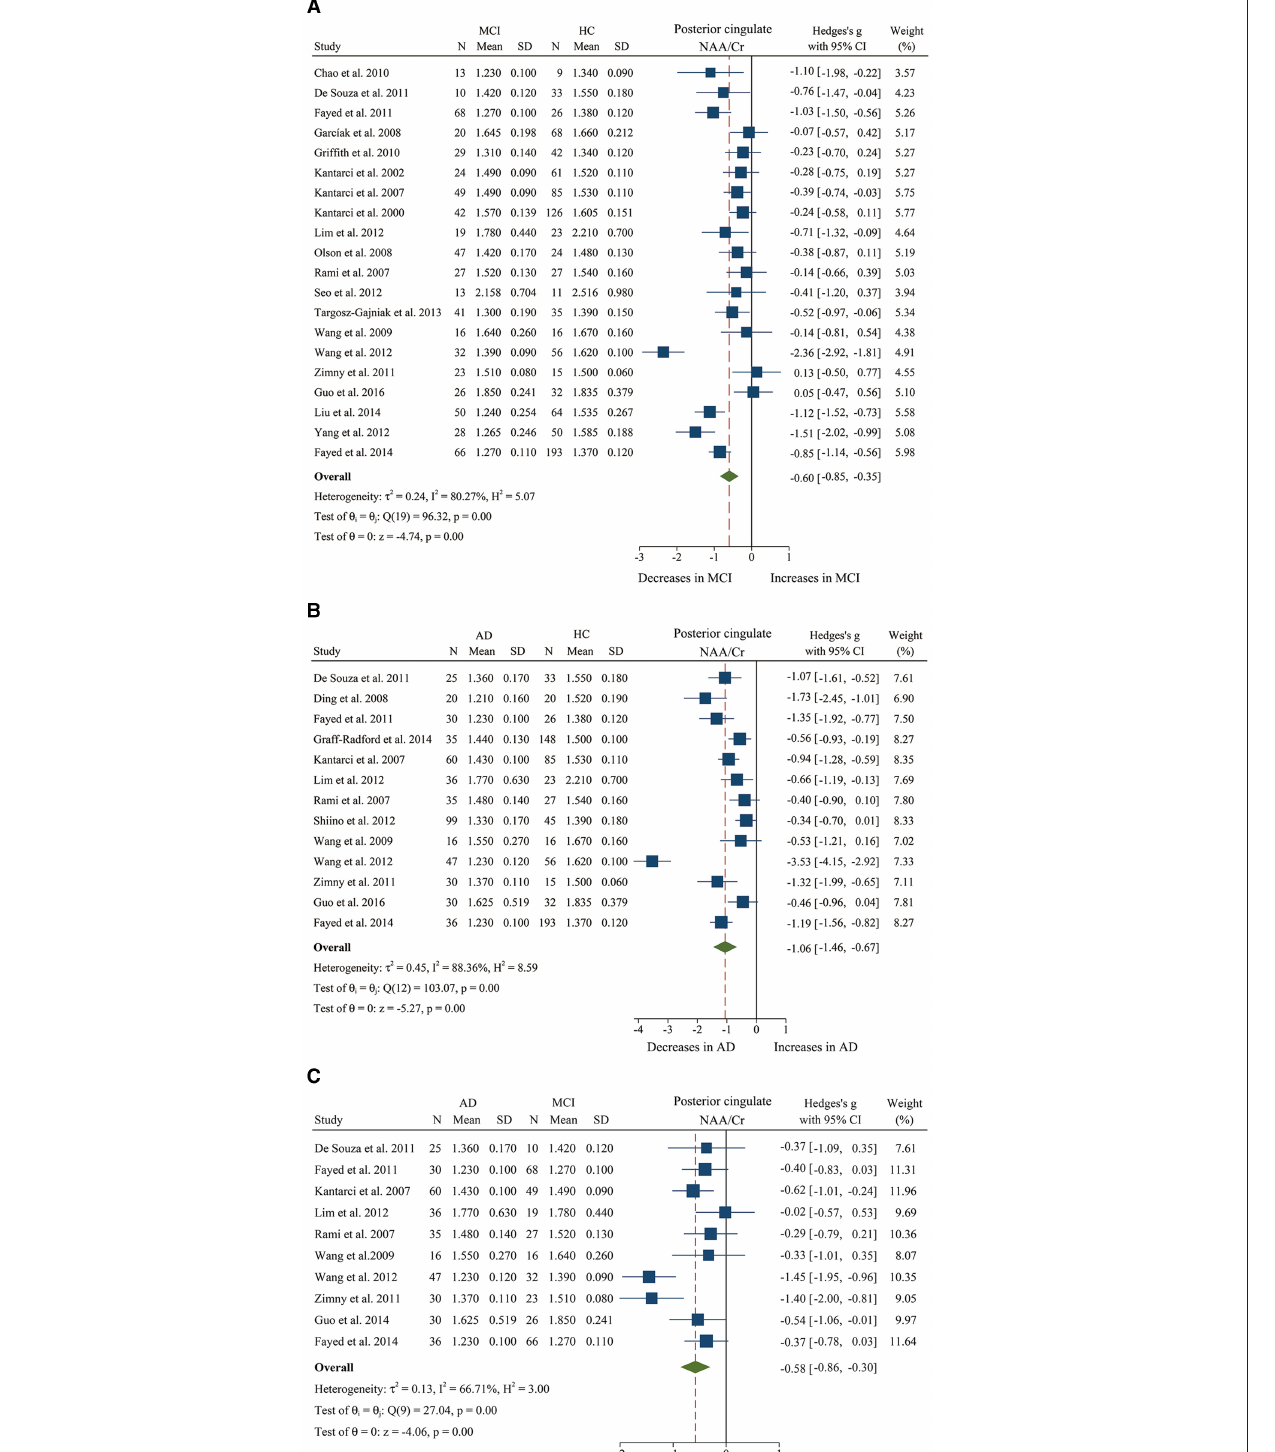
Frontiers in Aging Neuroscience |